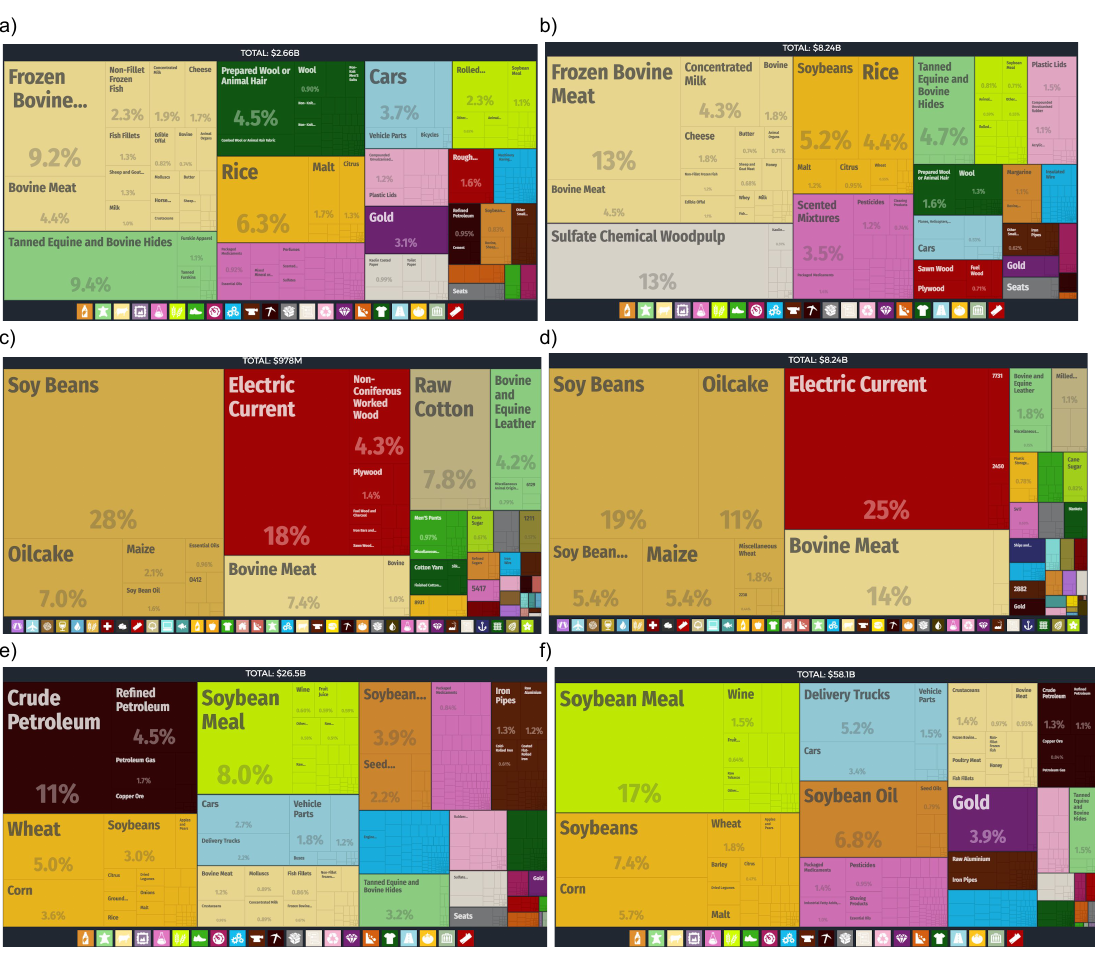
Figure A1.8. Export profiles in year 2000 (left) and 2015 (right) for Uruguay (a,b), Paraguay ​​ (c,d), Argentina (e,f). Areas are proportional to the export value in dollars per commodity. Source: Observatory of Economic Complexity, data from Comtrade FAO statistics. Interactive versions are available at ​